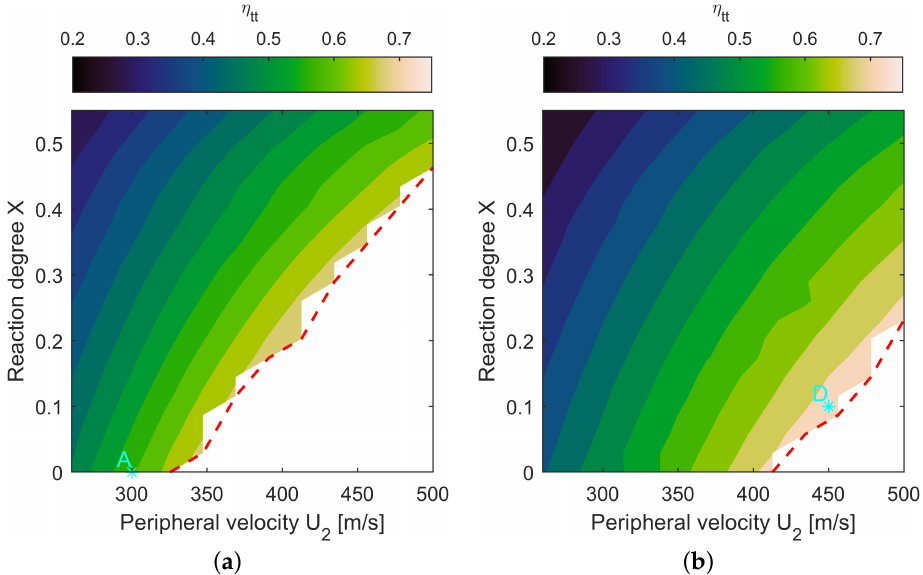
Figure 19. Stage total to total efficiency for stator blade height ratios of 1 ( a ) and 1.2 ( b ) with different reaction degree and peripheral